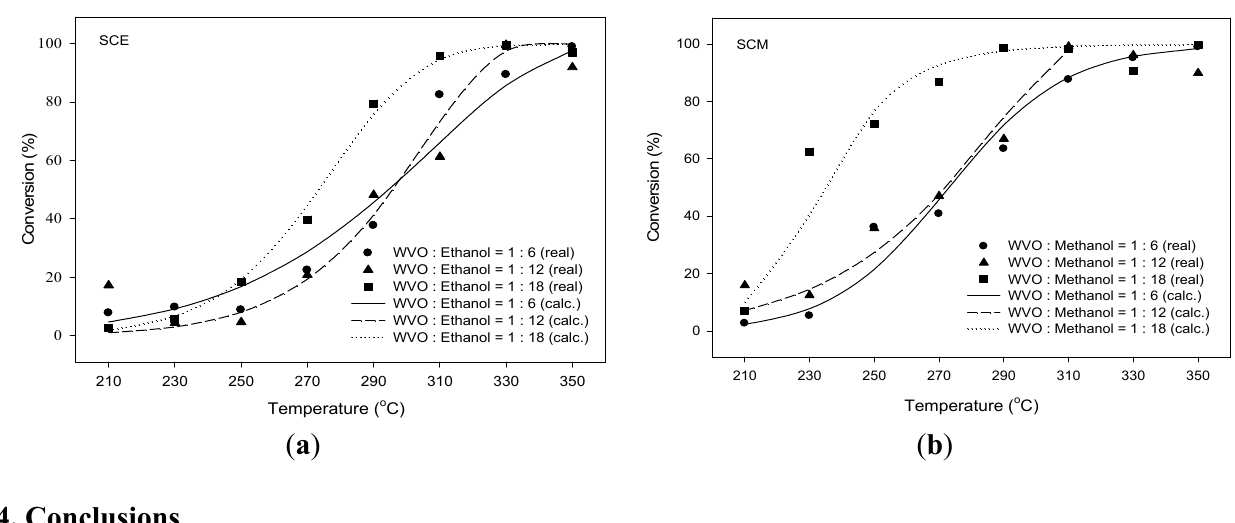
Figure 6. Comparison of experimental results (symbol) and calculated values (line) for ( a ) SCE and ( b )